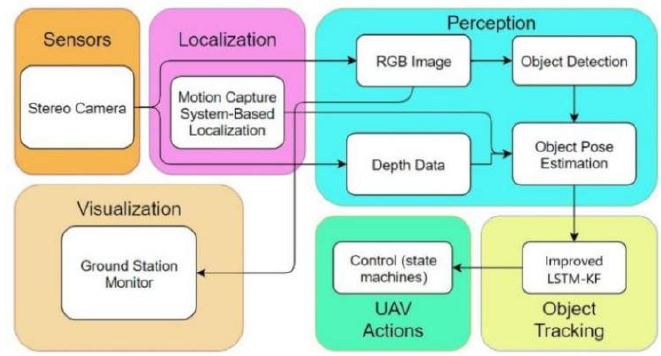
Figure 2. Software architecture of the system.